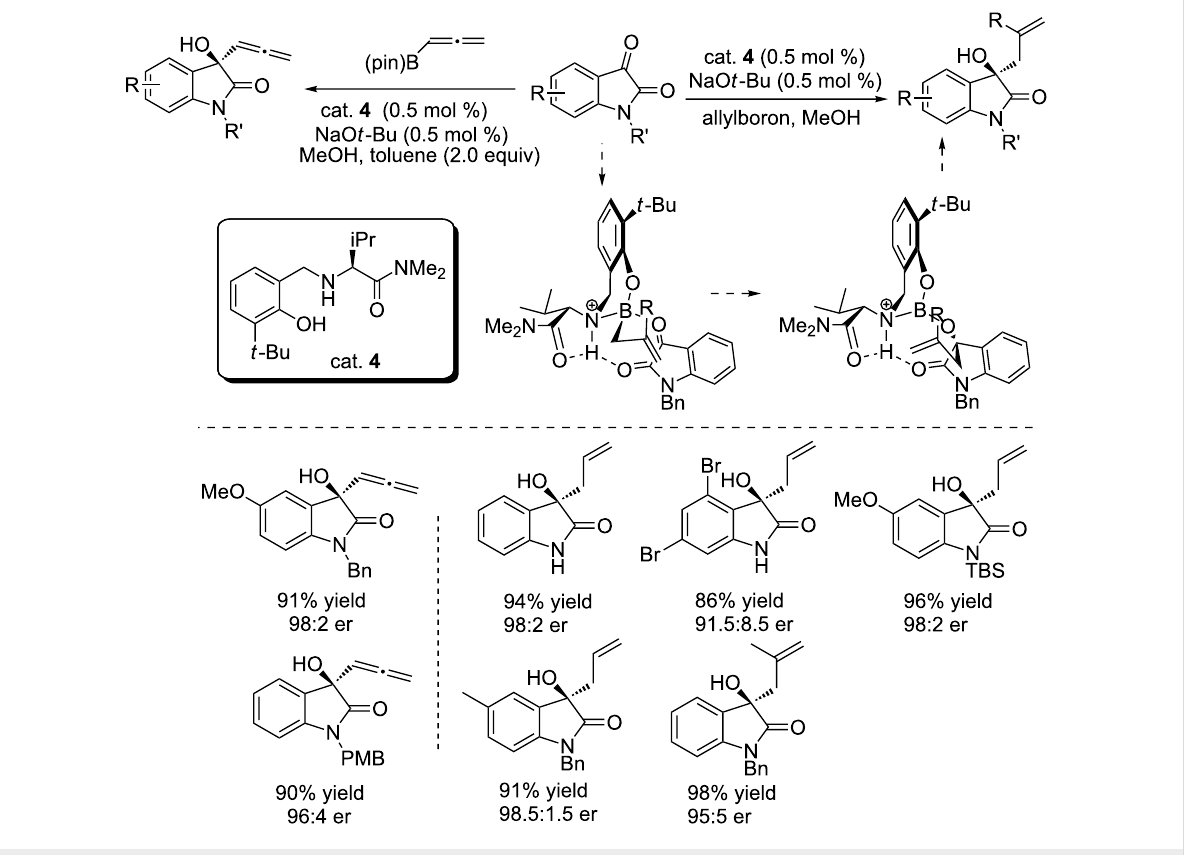
Scheme 16: Enantioselective additions of organoborons to